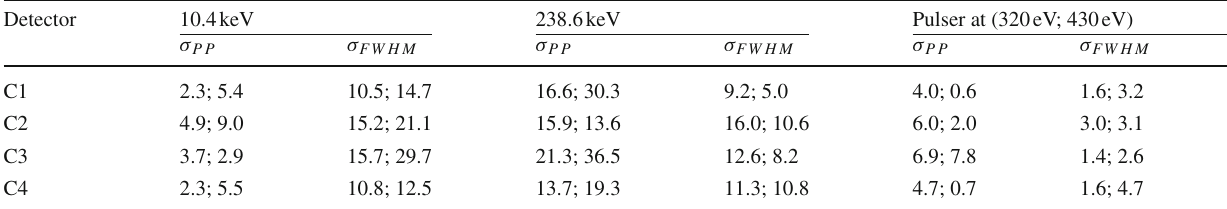
Table 12 Standard deviations (unit: eV ee ) of PP and Δ E of the 10.4keV X-ray and 238.6keV γ -ray line as well as of the pulser peak at (320eV; 430eV) during the described measurement periods ( Run -1; Run -2) of the Conus experiment